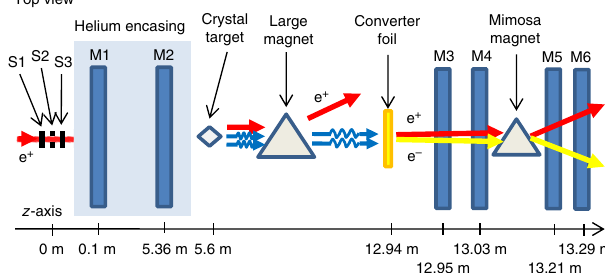
Fig. 1 Experimental setup. A schematic representation of the experimental setup in the H4 beam line in the SPS NA at CERN. The symbol S j , with j = 1, 2, 3 denotes the scintillators and the symbol M i , with i = 1, … , 6, denotes MIMOSA position sensitive